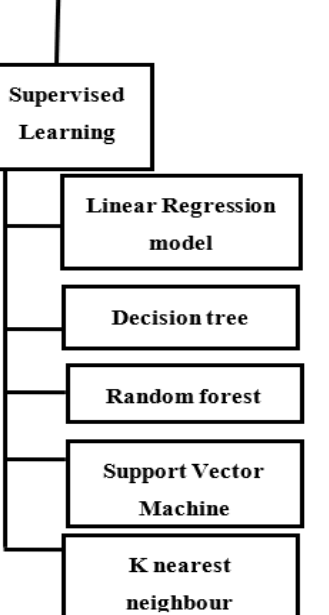
Figure 2. Classification of machine learning algorithms.